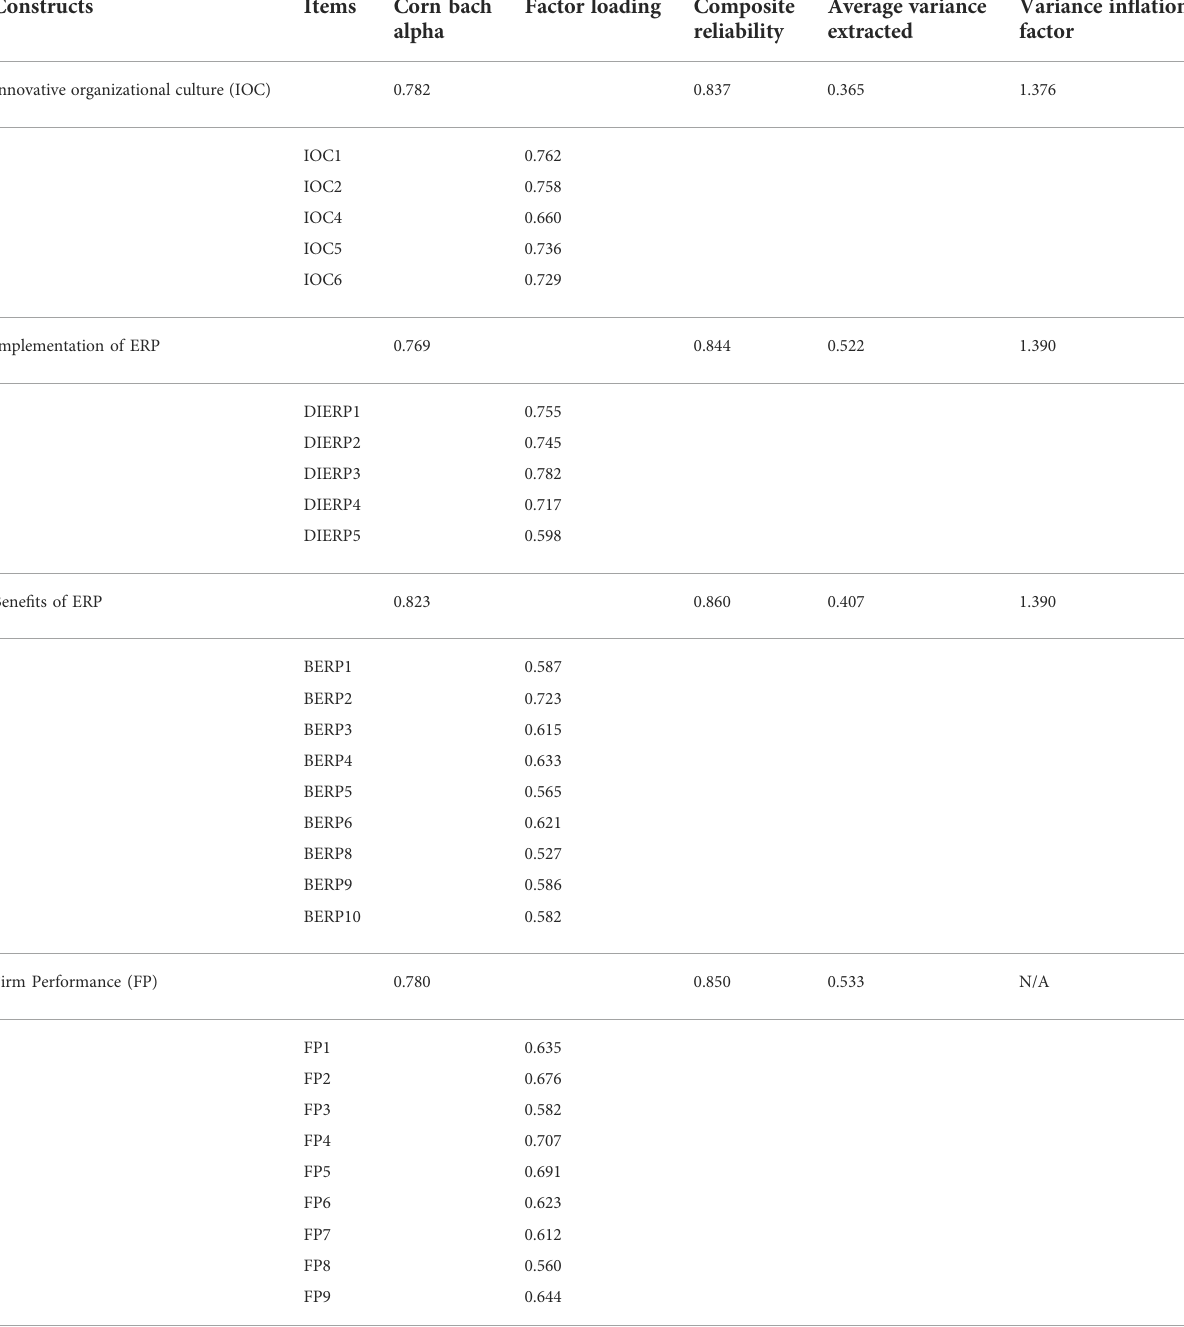
TABLE 3 Results of con fi rmatory factor analysis